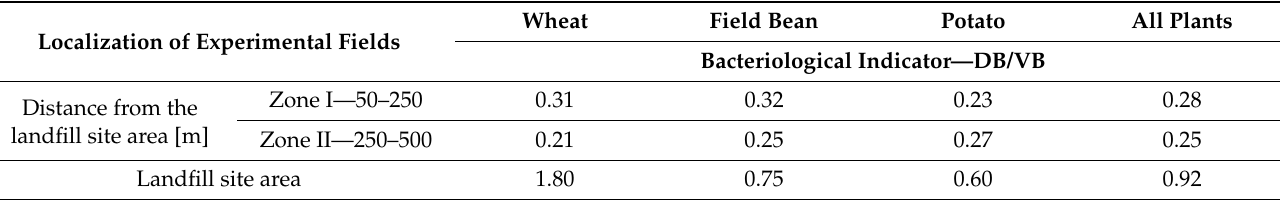
Table 5. Bacteriological indicator of soil quality depending on distance to the municipal landfill site (the ratio of the number of sporulating bacteria to the number of vegetative forms—own